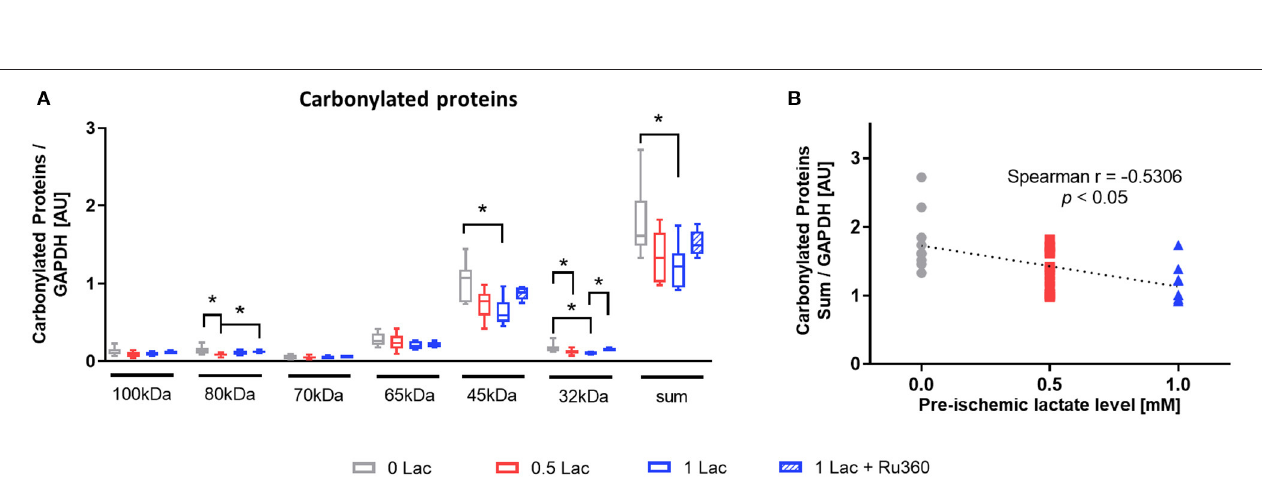
FIGURE 5 | Marker of oxidative stress damage. (A) Protein carbonylation measured by oxyblot at 60min of reperfusion (B) Spearman correlation of pre-ischemic lactate level with carbonylated proteins (sum) at 60min of reperfusion. * p < 0.05; n = 9–14/group. Data are expressed as median, 25–75 percentiles, and